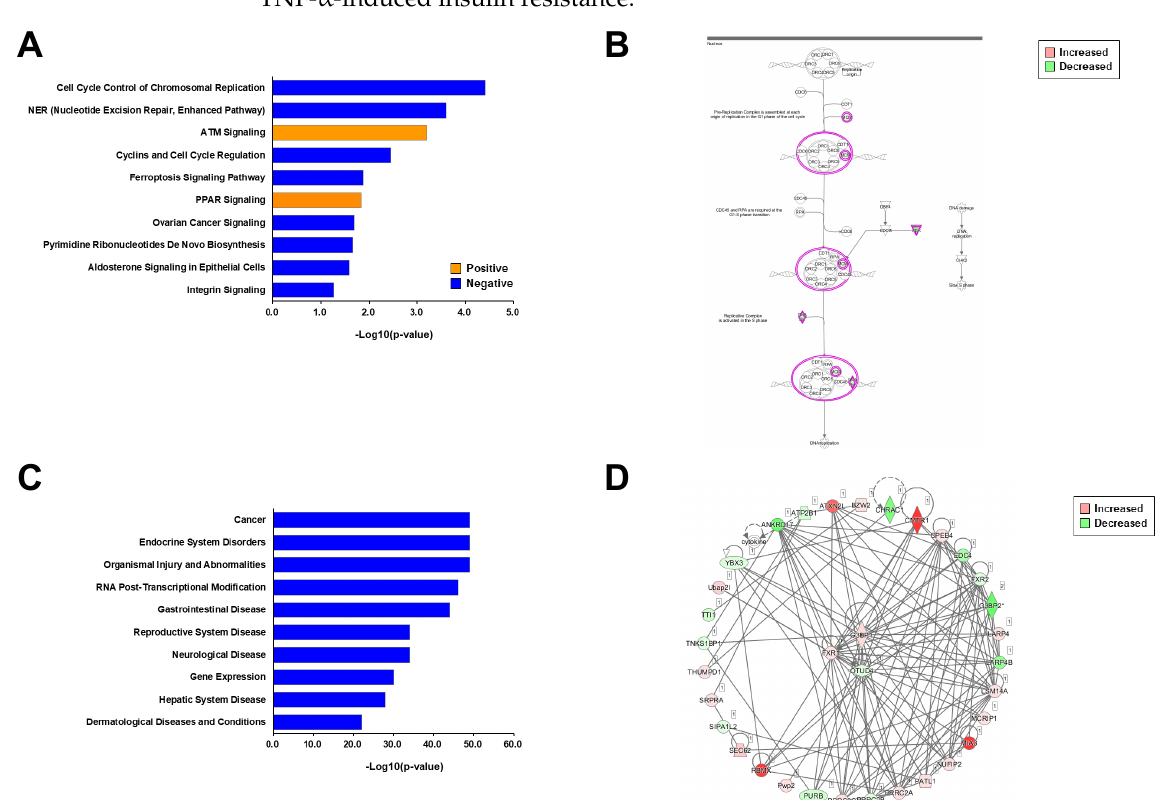
Figure 4. Informatic analysis of phosphoproteomes of TNF- α -induced insulin-resistant conditions. ( A ) Canonical pathway enrichment analysis of the 703 phosphoproteins. The positive and negative z-scores are shown in orange and blue, respectively. The x -axis indicates the − log10 ( p -value) of each pathway. ( B ) The cell cycle control of chromosomal replication pathway as the representative canon- ical pathway of phosphoproteomes of TNF- α -induced insulin-resistant conditions. The increased and decreased phosphorylation levels are shown in red and green, respectively. ( C ) Top 10 terms of disease relation and biological functions. The x -axis indicates the − log10 ( p -value) of each term. ( D ) Interactome analysis using the Top 10 terms of (cancer)-related phosphoproteins. The increased and decreased phosphorylation levels are shown in red and green,